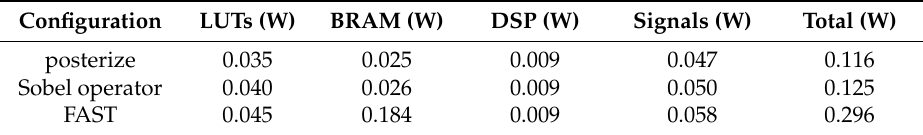
Table 6. The power consumption concerning the main elements of the hardware